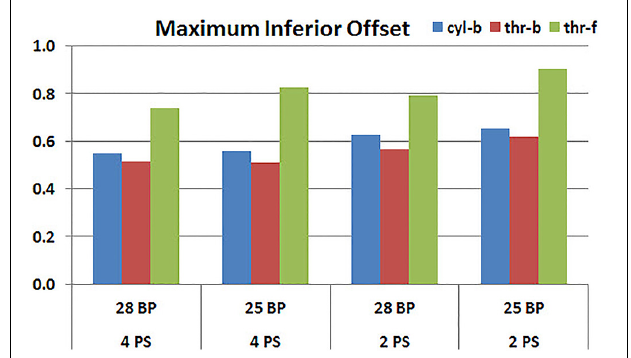
FIGURE 11 | Interfacial micromotion results using 28 and 25 mm baseplates (28 BP and 25 BP) and four and two peripheral screws (4PS and 2PS), with maximum inferior offset.